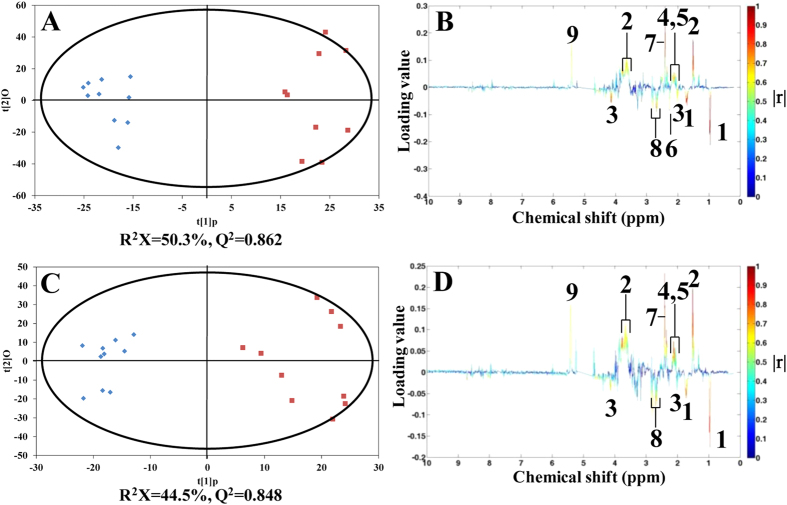
OPLS-DA score plots derived from 1H NMR spectra of gill tissue extracts from the control (♦) and exposed (■) blood clam groups with (A) 25 and (C) 250 μg/L Cd, respectively, after exposure for 24 hours and corresponding coefficient plots (B,D). The most significant metabolic variations between Cd exposure and control group are shown in the coefficient plots: positive directed peaks for up-regulated metabolites in Cd exposure group; negative directed peaks for down-regulated metabolites. Key: (1) leucine, (2) alanine, (3) proline, (4) glutamate, (5) glutamine, (6) acetoacetate, (7) succinate, (8) aspartate and (9) glycogen.